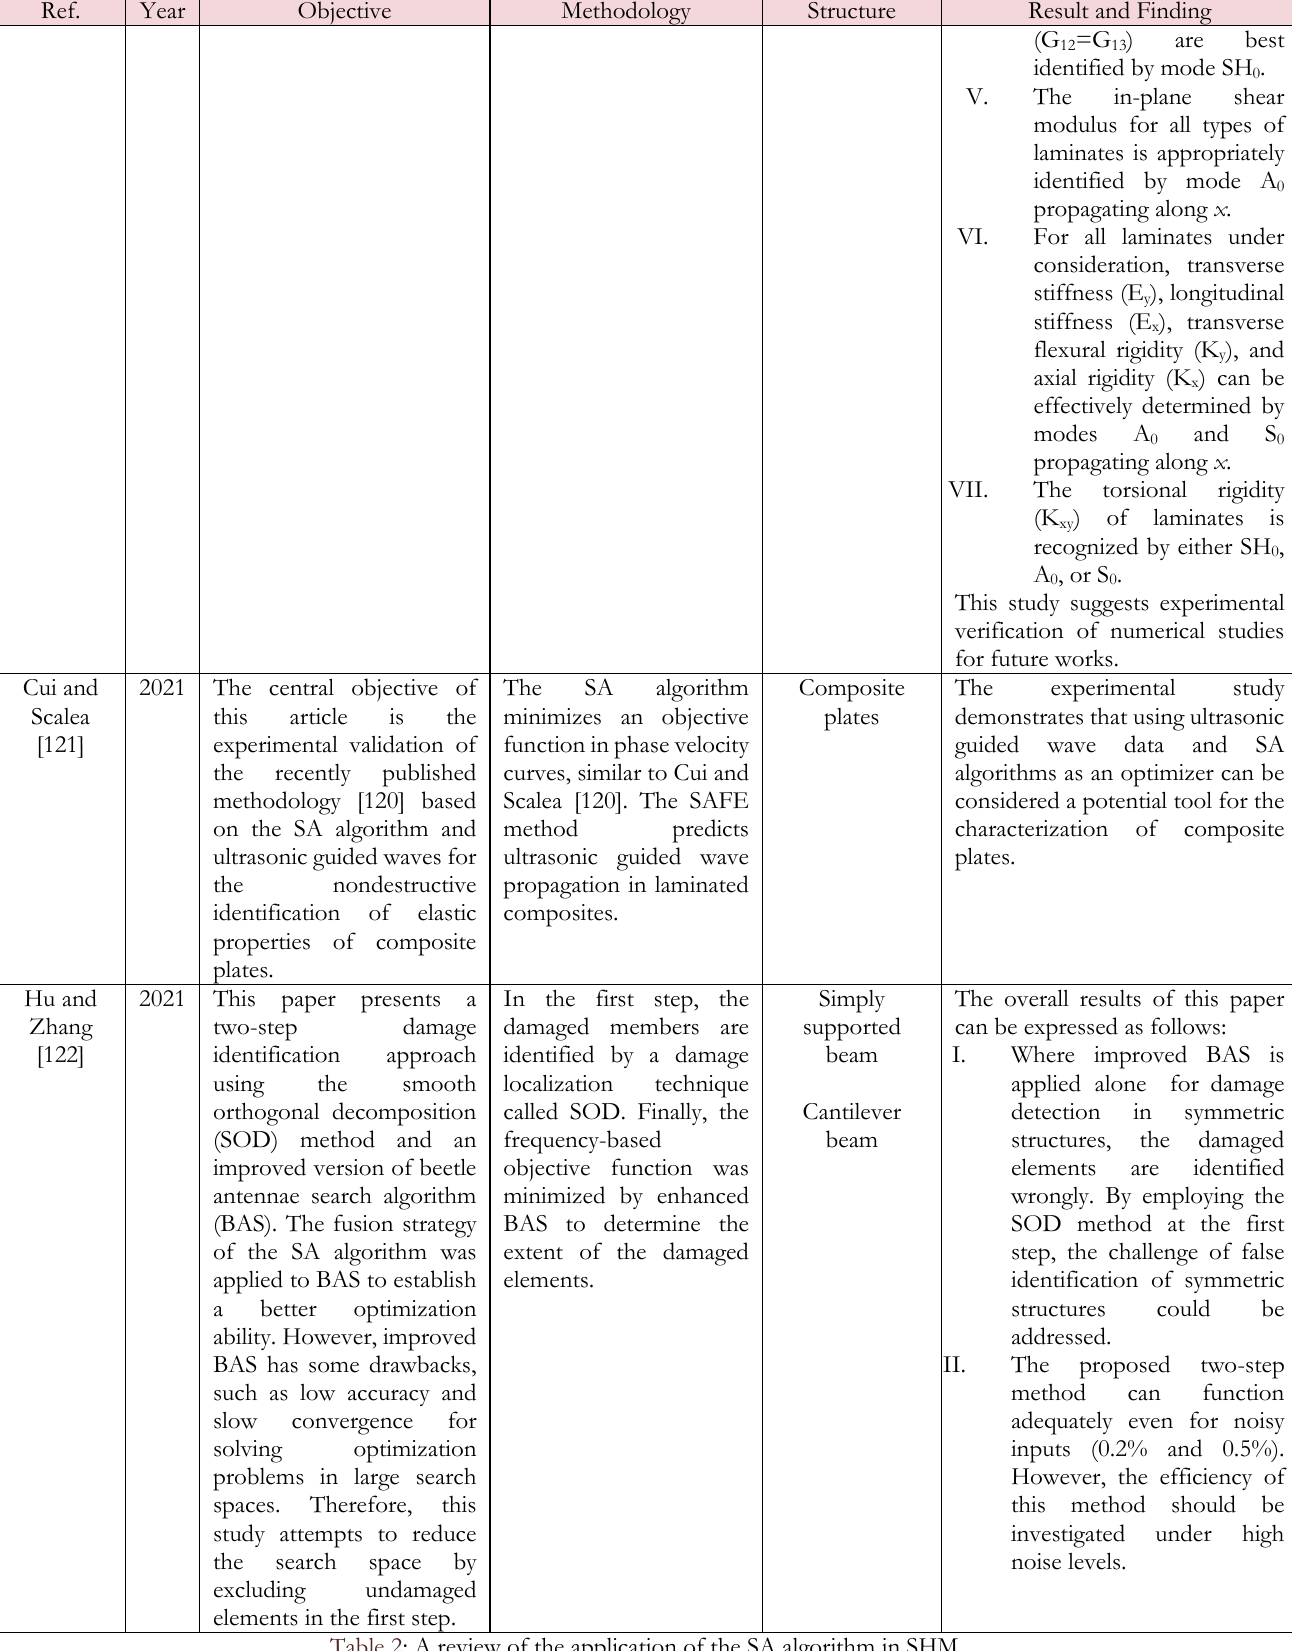
Table 2: A review of the application of the SA algorithm in